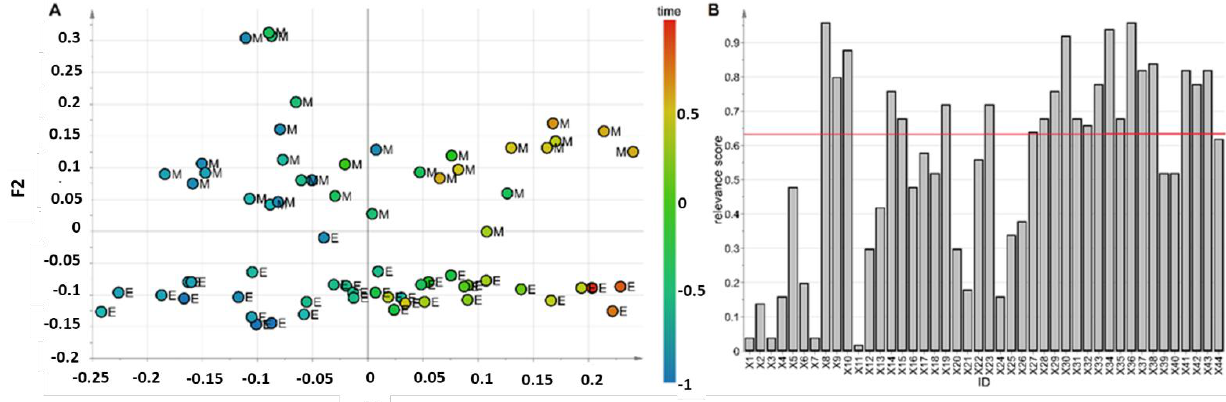
Figure 3. Multivariate data model of the data set arising from annotated spectra. Panel ( A ): Latent factor scatter plot colored according to time; M and E labels indicate milk samples from mothers delivering moderately and extremely preterm, respectively. Panel ( B ): Relevance score plot; the red line indicates the threshold at the level of α = 0.05 used for discovering relevant features. The meaning of the feature codes is reported in Table S2 in the Supporting